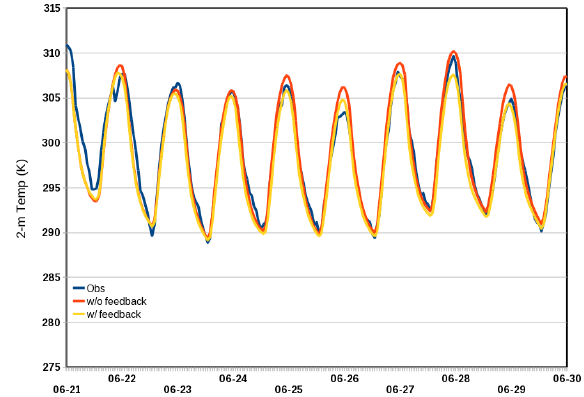
Figure 8. Surface (2-m) temperature comparison of averaged measurements (blue) from four sites 2 Fig. 8. Surface (2-m) temperature comparison of averaged mea- surements (blue) from four sites (Oroville, Red Bluff, Redding and (Oroville, Red Bluff, Redding and Sacramento) with model simulation with (yellow) and without (red) 3 Sacramento) with model simulation with (yellow) and without (red) direct aerosol